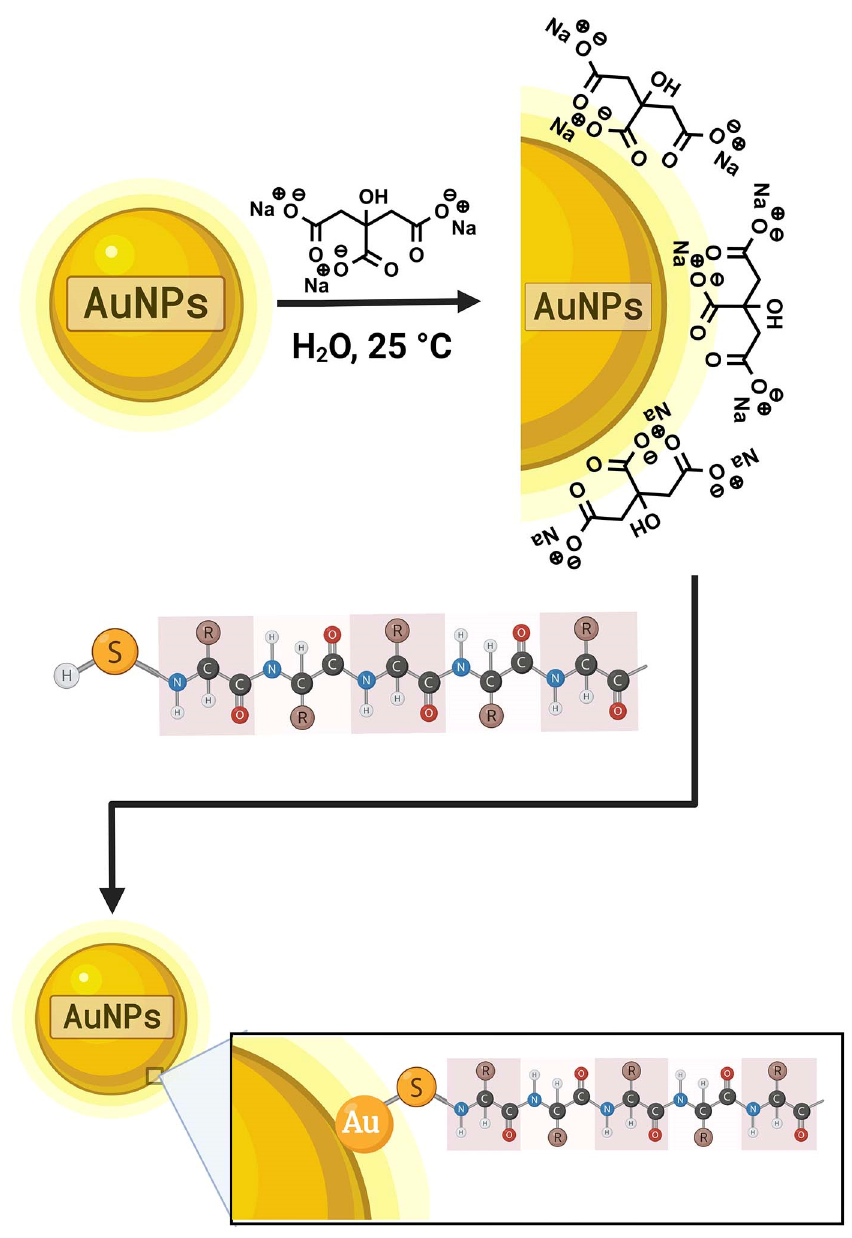
Figure 2. Mechanism of gold nanoparticles functionalization by covalent bonding. The sodium citrate acts as a stabilizer when it is absorbed into AuNPs. Subsequently, a second chemical reaction with the sulfhydryl group of functionalization molecules reacts with metallic gold forming the Au–S covalent